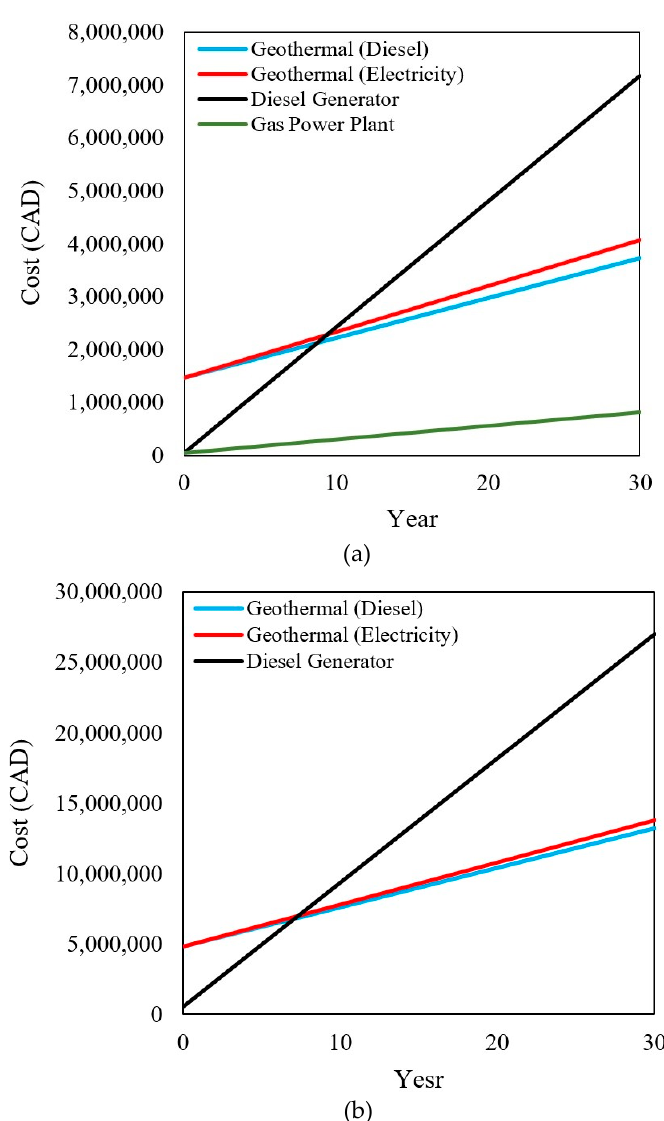
Figure 7. Comparison of different energy production systems in terms of cost for the considered communities in (a) ON and (b) Resolute.